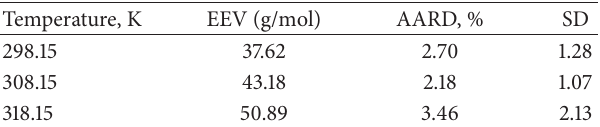
Table 3: EEV values (2) of PEG 6000 + sodium succinate + water at different temperatures.